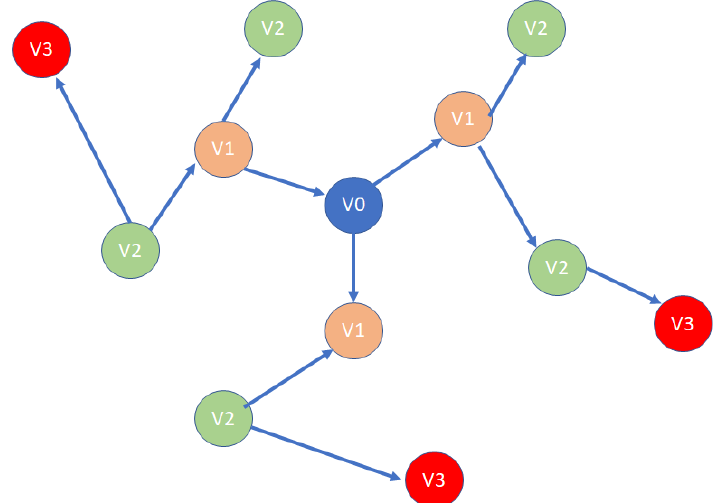
Figure 1. K -hop neighborhood. The blue node is the source node, the area that covers the yellow nodes is the 1-hop neighborhood, the area that covers the yellow and green nodes are the 2-hop neighbors, and the area that covers the yellow, green and red nodes is the 3-hop